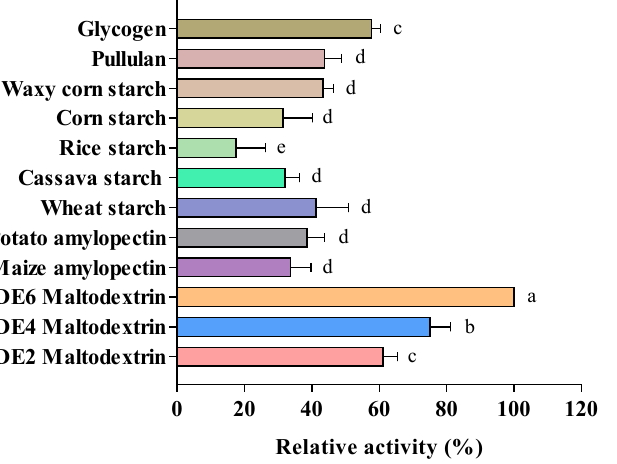
Figure 2. Substrate specificity of purified AMY. All data are means ± SD ( n = 3). Means with different letters within the same group are significantly different ( p < 0.05).